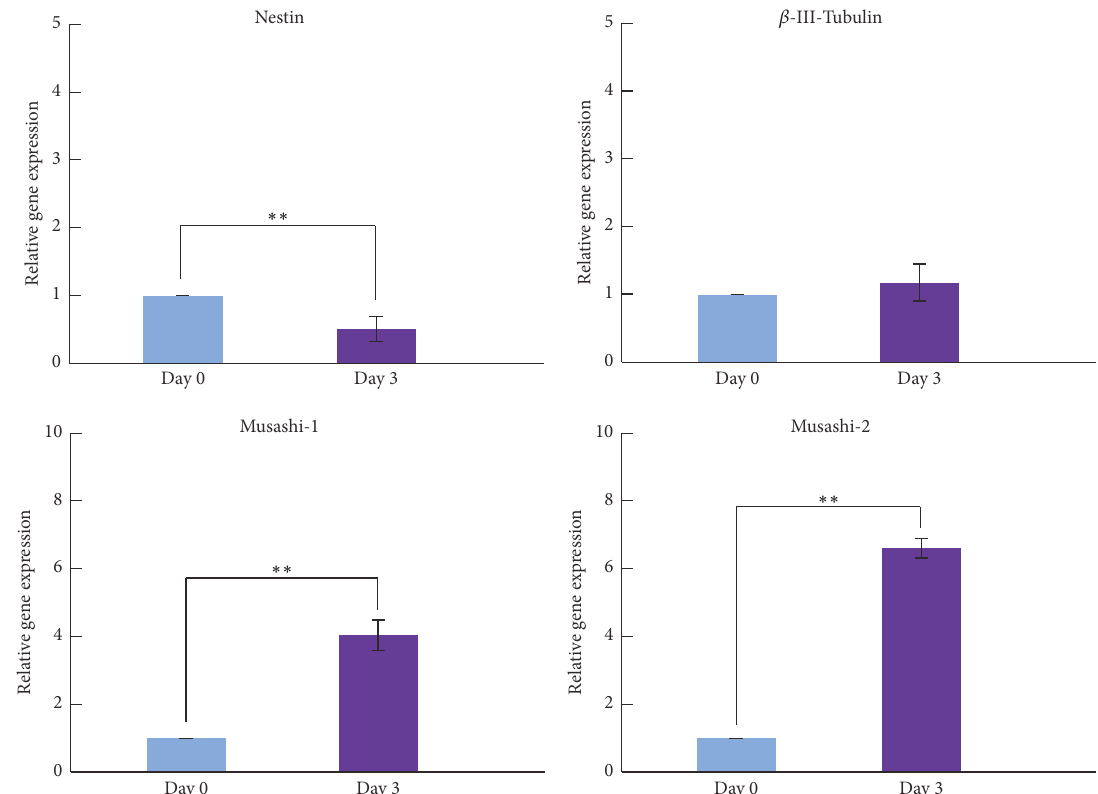
Figure 3: Gene expression of neural markers in hDFCs during one-step neuronal induction. Gene expression was compared in hDFCs between the undifferentiated condition and 3 days after one-step neuronal induction. Values represent means ± SD (𝑛 = 3) . ∗∗ 𝑝 < 0.01 .